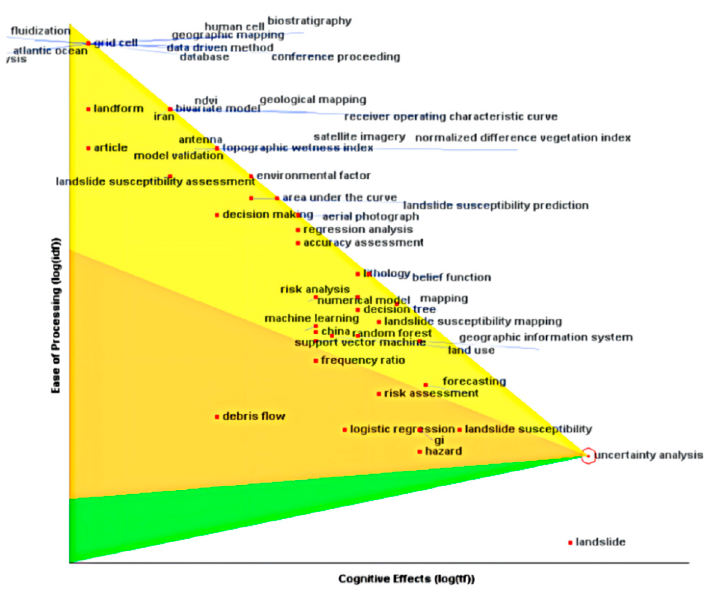
Figure 12. Uncertainty analysis pennant plot.